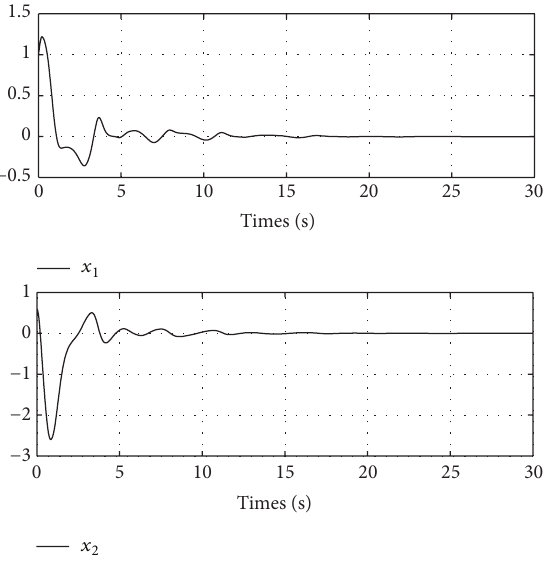
Figure 1: State trajectories of 𝑥(𝑡) in (28).